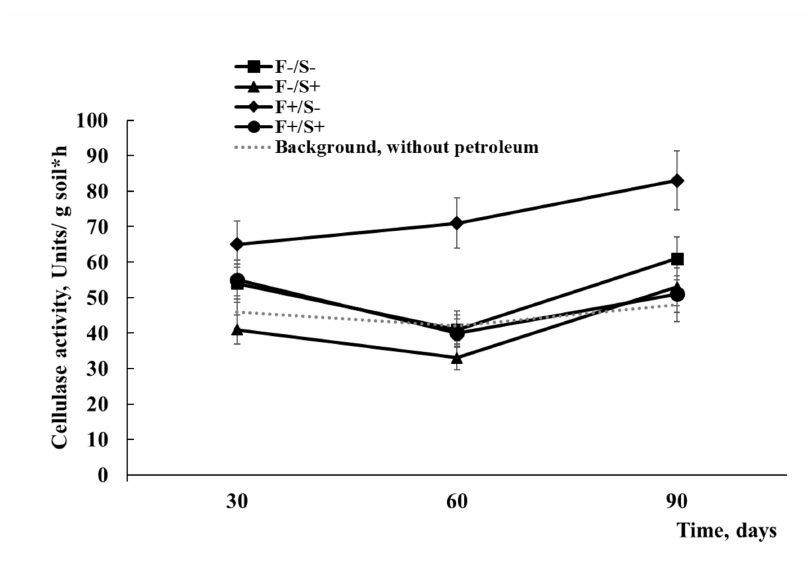
Figure 4. The dynamics of cellulase activity in bog soil under various options for remediation.